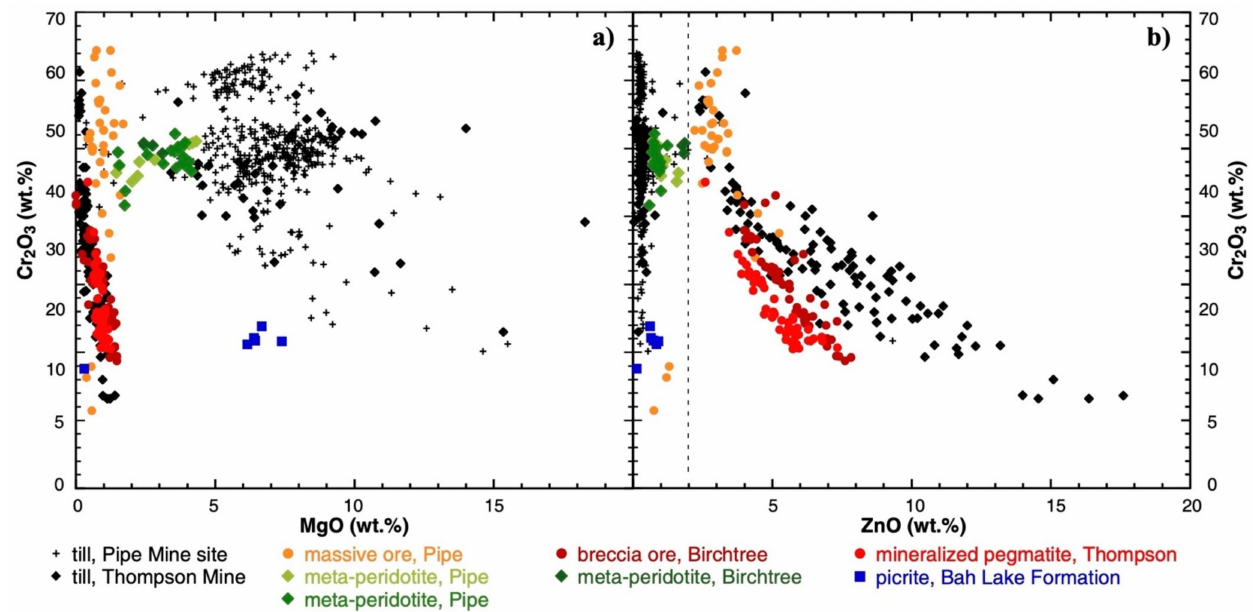
Figure 12. ( a ) Cr 2 O 3 versus MgO and ( b ) Cr 2 O 3 versus ZnO concentrations in chromian spinels from bedrock and till samples from the Thompson Ni Belt: mineralized bedrock (orange and red symbols), unmineralized bedrock (blue and green symbols), and till samples (black symbols). Dashed vertical line indicates 2 wt % ZnO. Modified from McClenaghan et al. (2013)